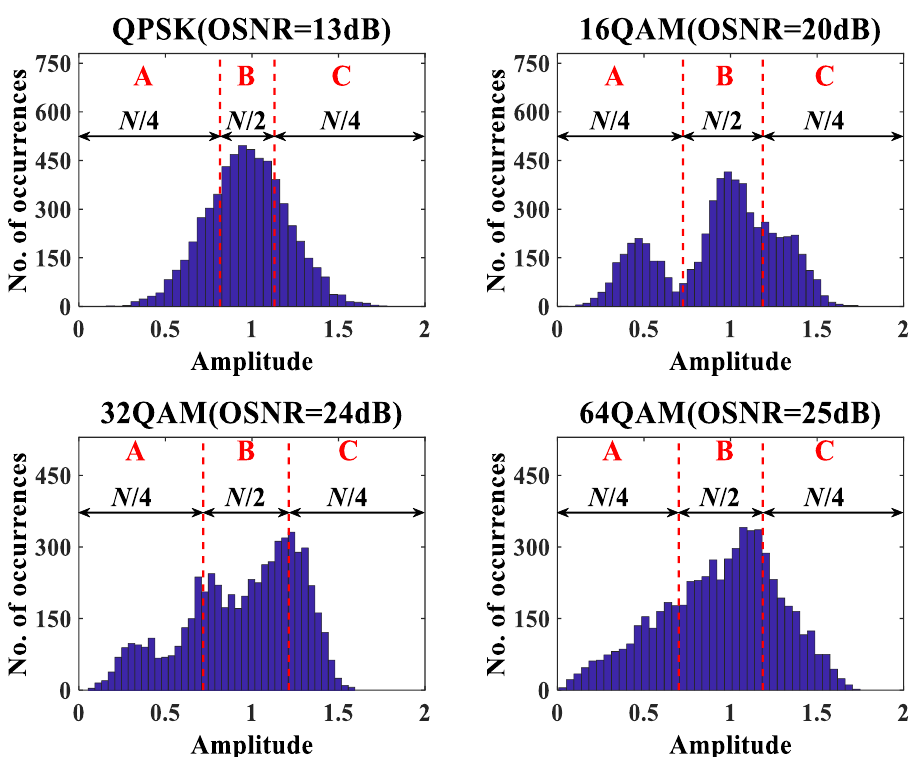
Figure 4. The second partition operation for the amplitude histograms of QPSK, 16QAM, 32QAM and 64QAM. The amplitude histograms of the four modulation formats are divided into part A, B and C. The number of symbols in part A, B and C are N /4, N /2 and N /4, respectively.